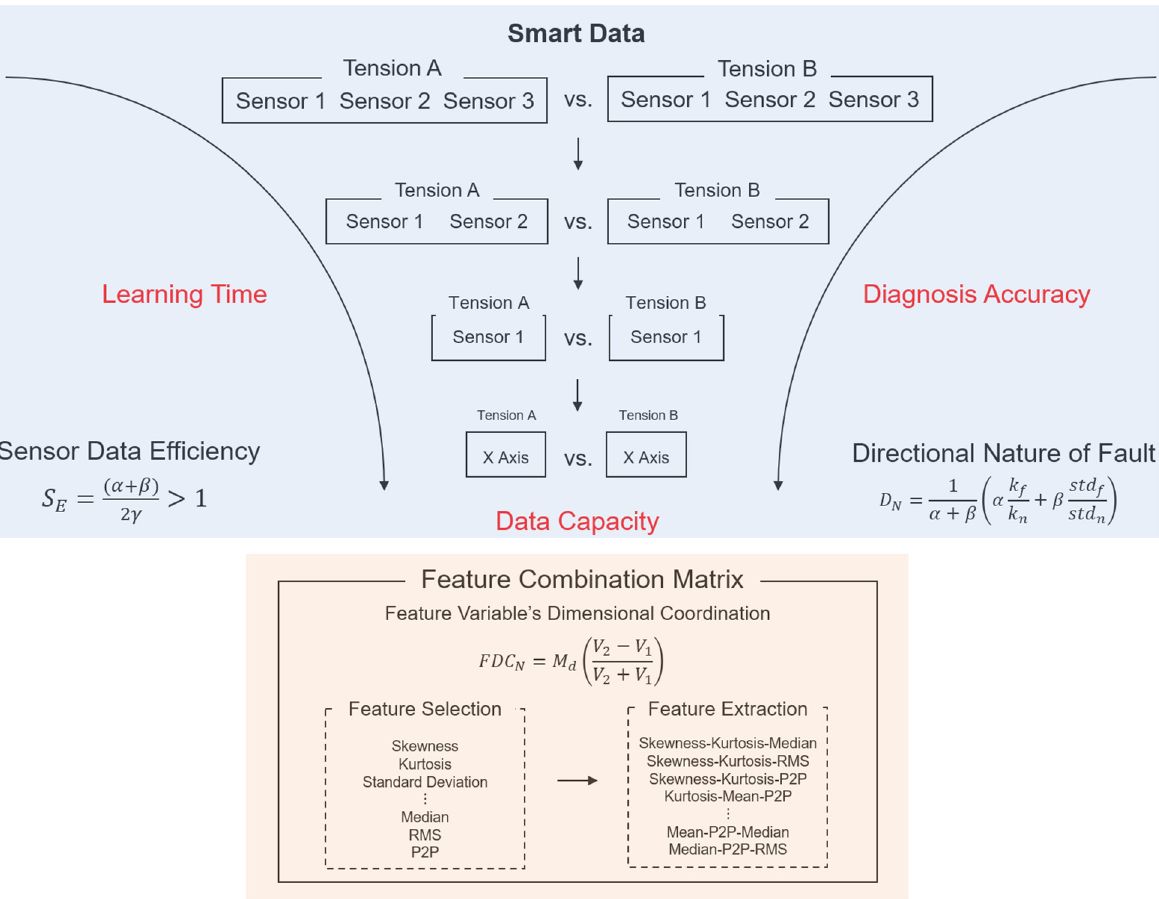
Figure 1. Smart data characterization procedure from raw data.